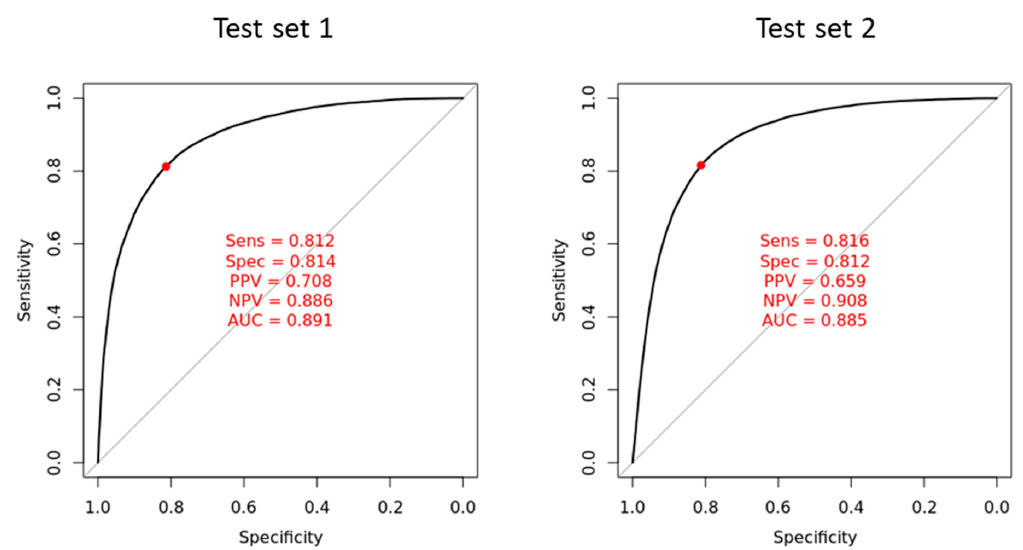
Figure 3. The ROC curves from XGBoost model in two test cohorts. The ROC curves ( x -axis = specificity and y -axis = sensitivity) and AUCs were calculated using the testing sets. The operating point was selected based on the maximum of Youden’s index in the validation cohort, and was used for calculating the corresponding sensitivity and specificity. Table 2. Model parameters from the validation and test cohorts.